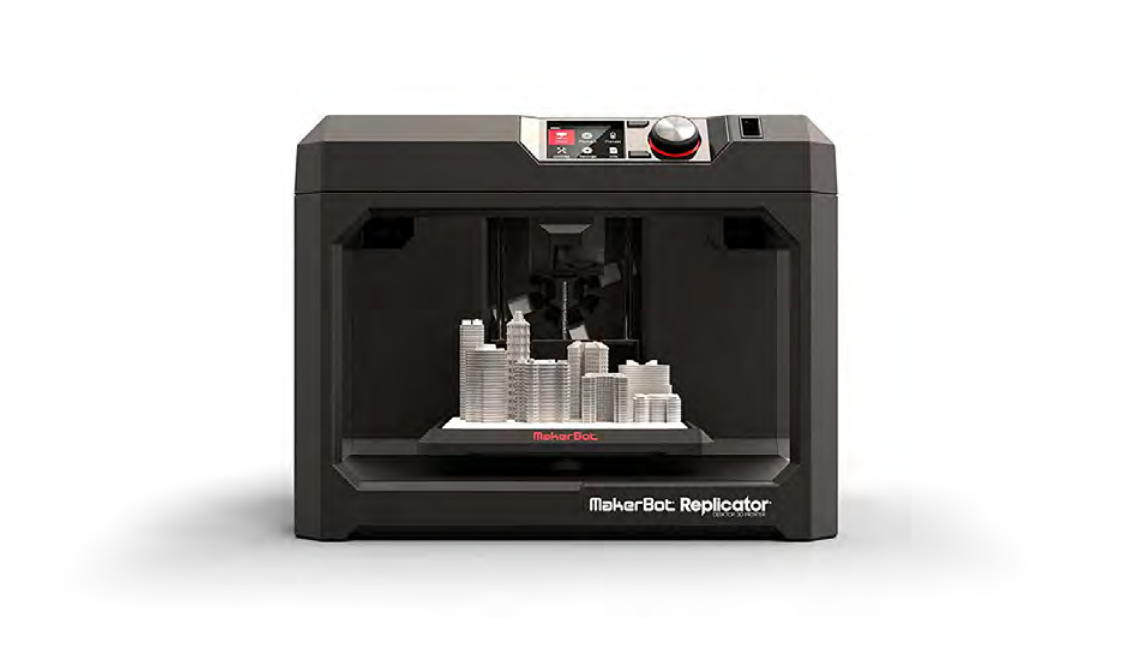
Figure 3. Cartesian type 3D printer